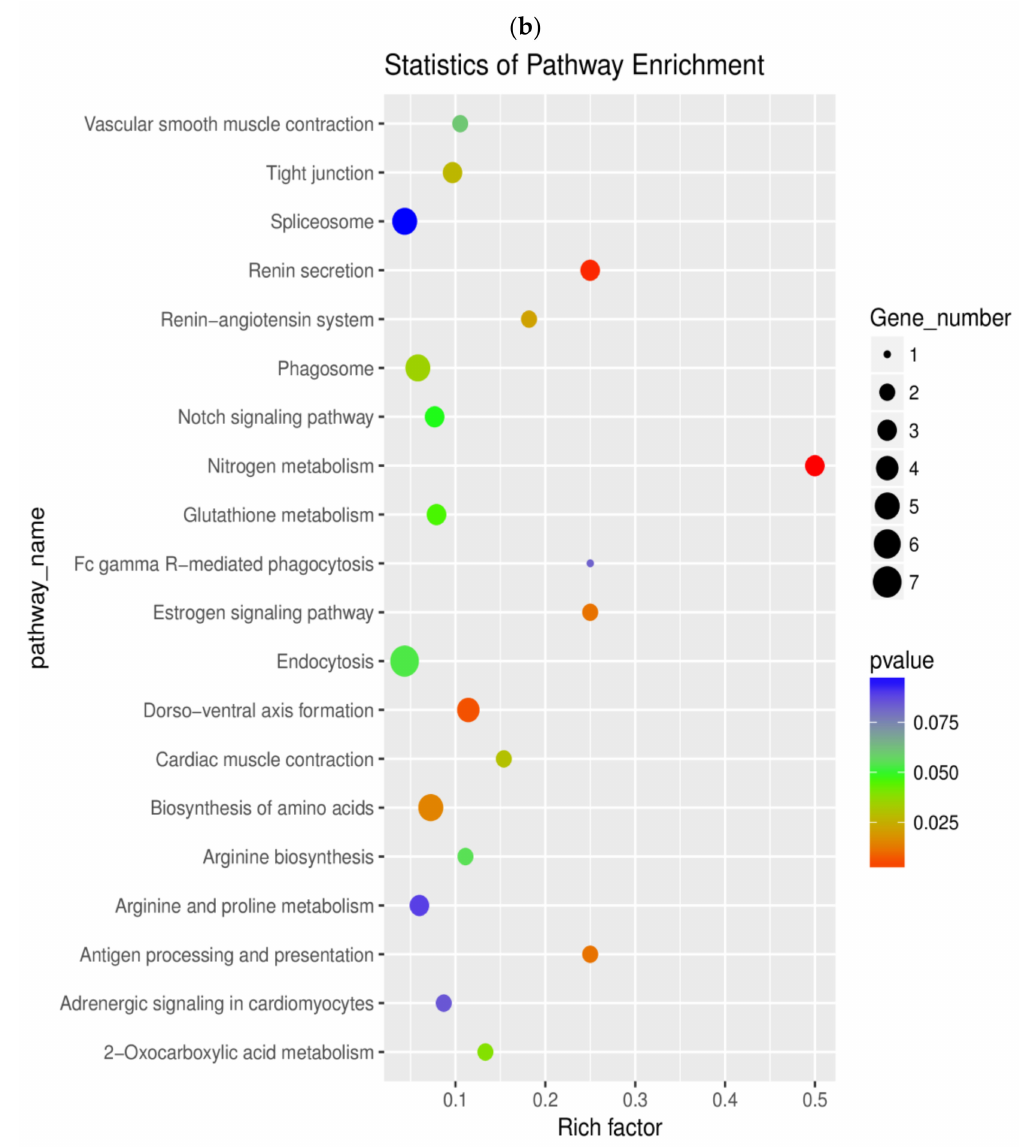
Figure 3. Scatterplot of the top 20 enriched Kyoto Encyclopedia of Genes and Genomes (KEGG) pathways. Rich factor represents the ratio of the number of DEGs and the number of all genes in the pathways. ( a ) KEGG pathway enrichment of DEGs in T_1h vs. CON. ( b ) KEGG pathway enrichment of DEGs in T_3h vs.